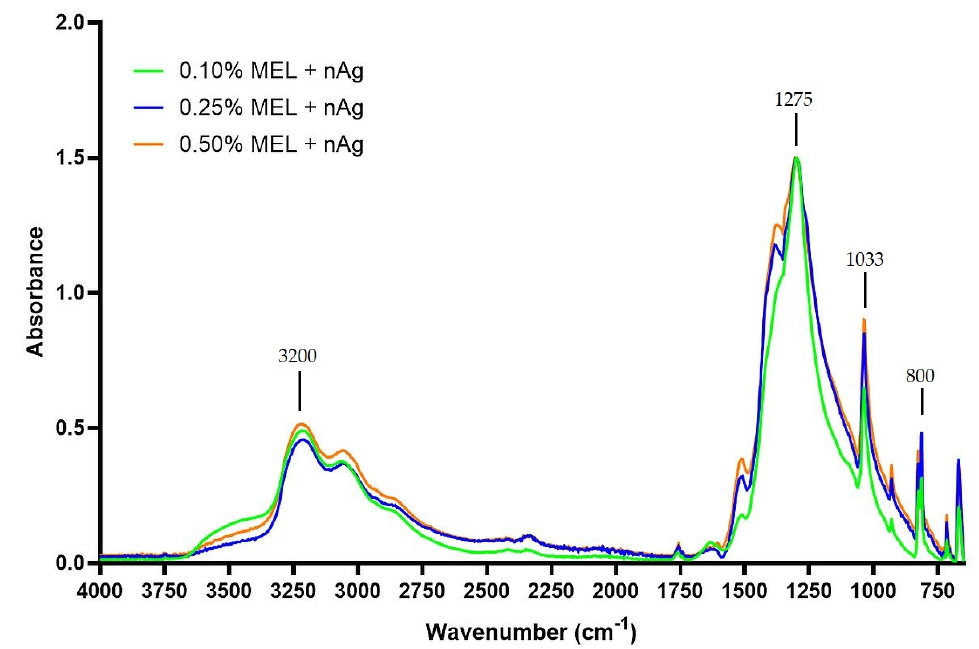
Figure 2. FTIR spectra of obtained silver nanoparticles samples.